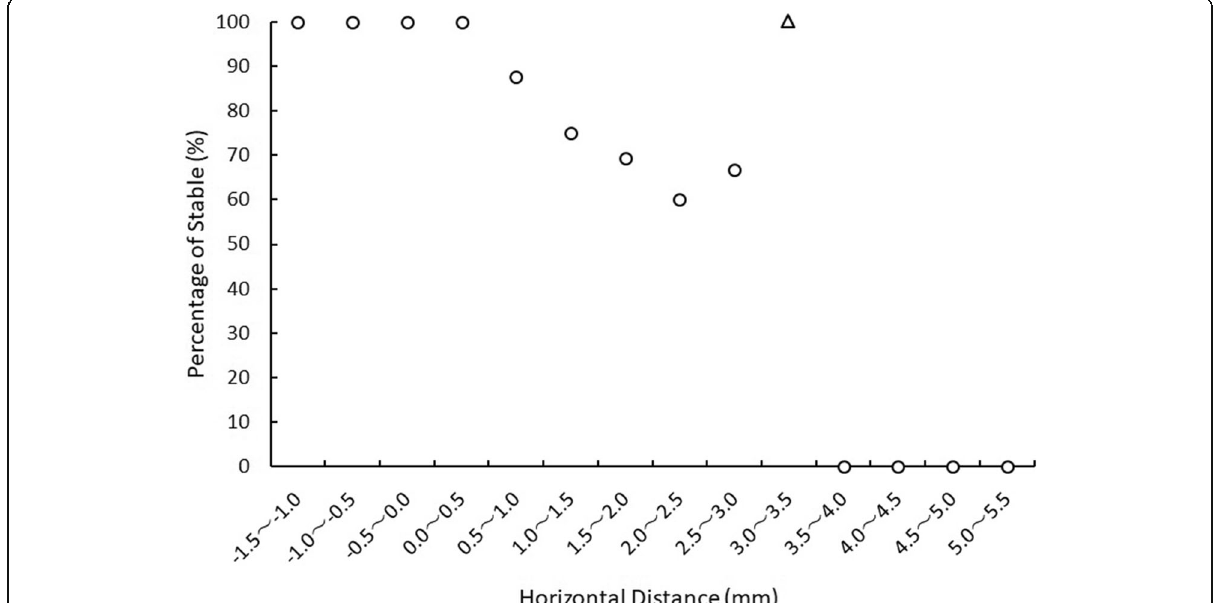
Fig. 4 The percentage of stable cases relative to the pretreatment horizontal distance. The open triangle indicates an outlier. The occurrence of unstable cases started when the horizontal distance was more than 0.5 mm, and when this distance exceeded 3.5 mm, the percentage of stable cases was